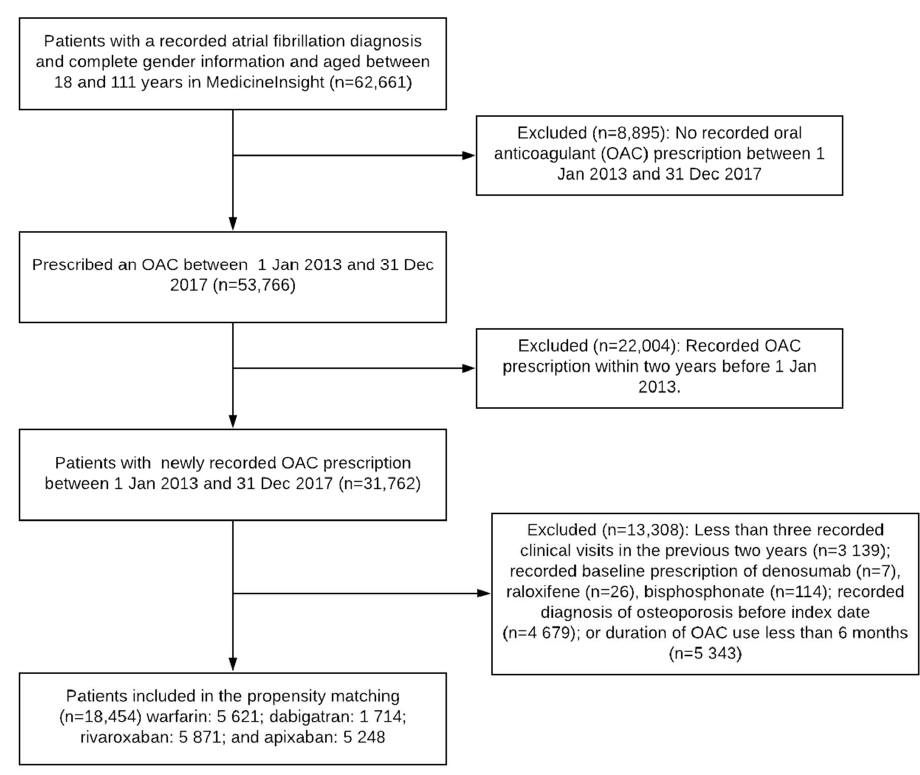
Figure 1. Selection of cohort. Table 2. The incidence of newly-diagnosed osteoporosis in the study